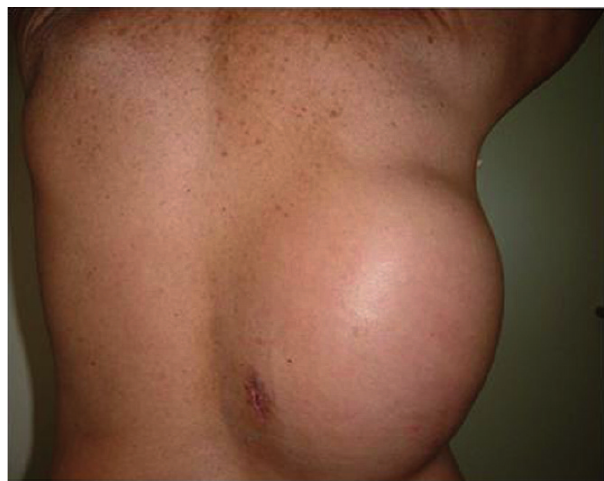
Figure 1 - Patient presenting a large desmoid tumor on the posterior thoracic wall.